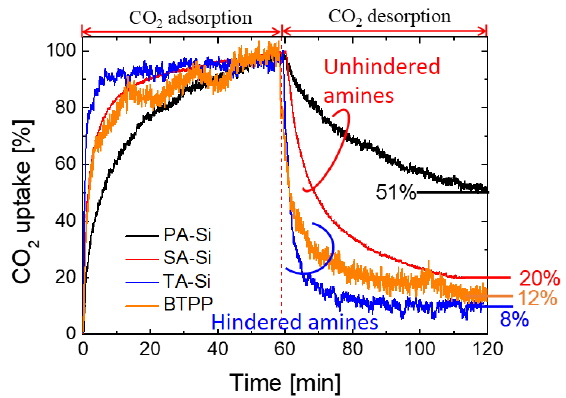
Figure 12. Time course of normalized CO 2 adsorption amount for the 1st cycle of a CO 2 adsorption/desorption process for amine-functionalized organosilica xerogel powders performed on TG/DTA equipment. A 60 vol% of CO 2 in a CO 2 -Ar mixture with a flow rate of 50 cm 3 /min and a total pressure of 100 kPa was adopted for the CO 2 adsorption process, while pure Ar with the same flow rate and pressure was used for CO 2 desorption process. The samples were activated by heating at 200 °C for 12 h, followed by cooling to 35 °C under a pure Ar atmosphere. Results were reorganized from refs. [21,22].